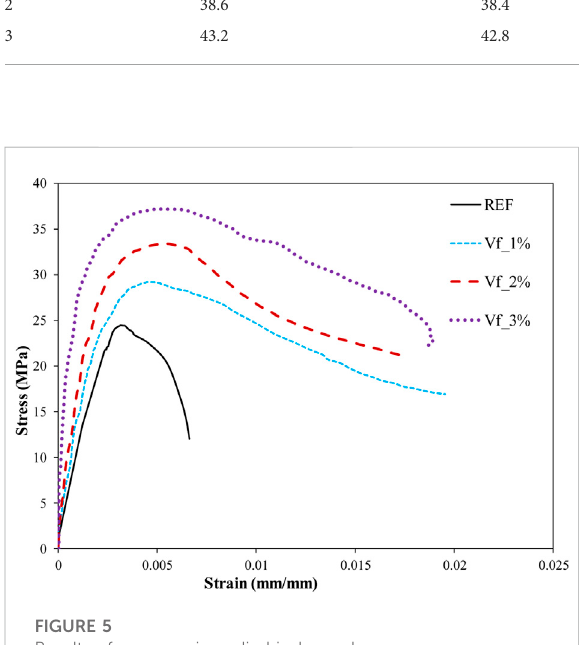
FIGURE 5 Results of compressive cylindrical